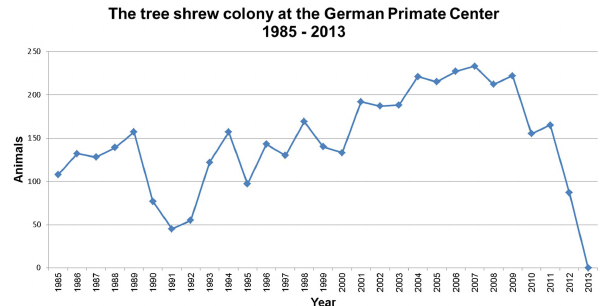
Figure 3. The development of the tree shrew colony of the DPZ from 1985 to